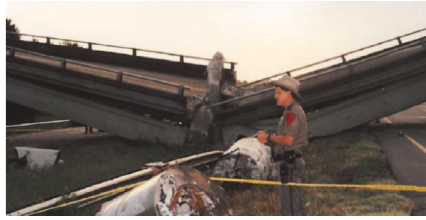
Figure 1: Bridge collapse [2].